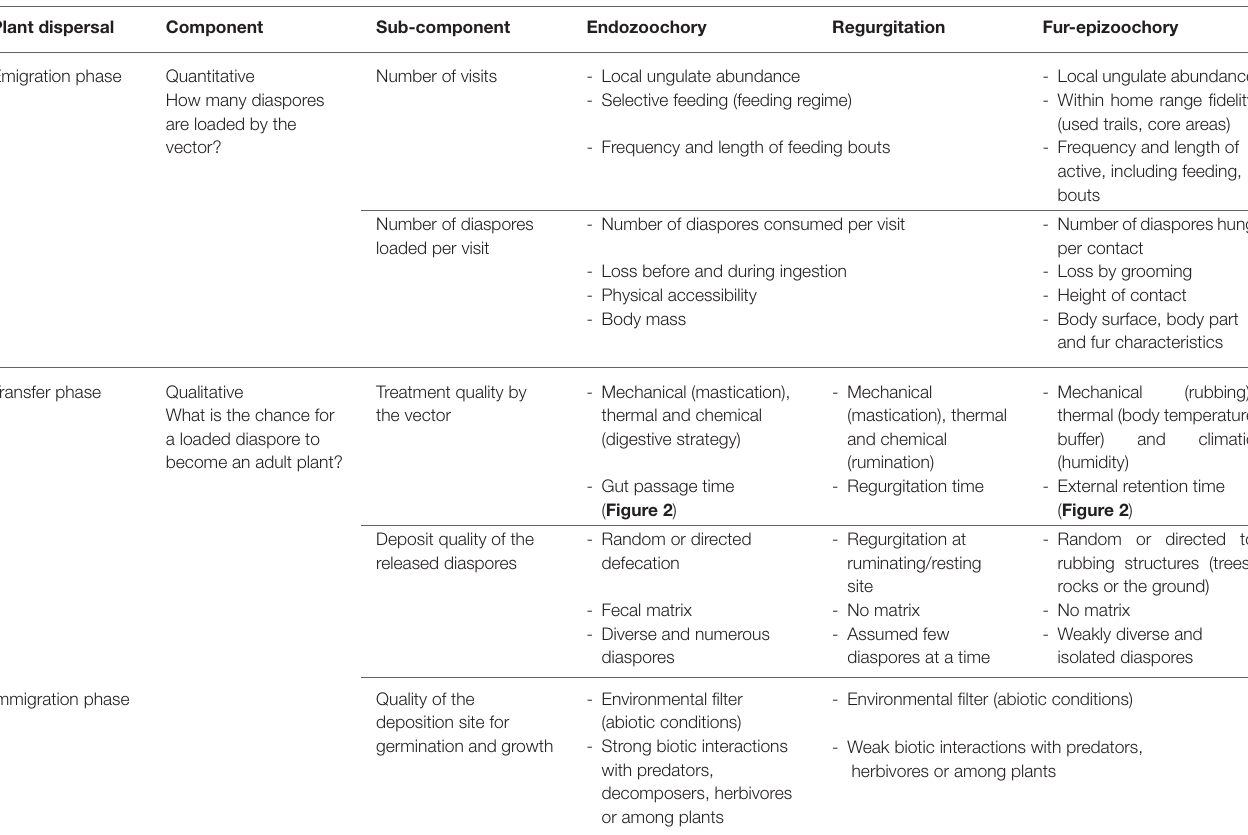
TABLE 1 | Components of ungulate-mediated seed dispersal effectiveness comparing three primary processes: endozoochory, regurgitation and fur-epizoochory [modified from Table 1 in (Schupp, 1993), and Figure 2 in Schupp et al., 2010]. Plant